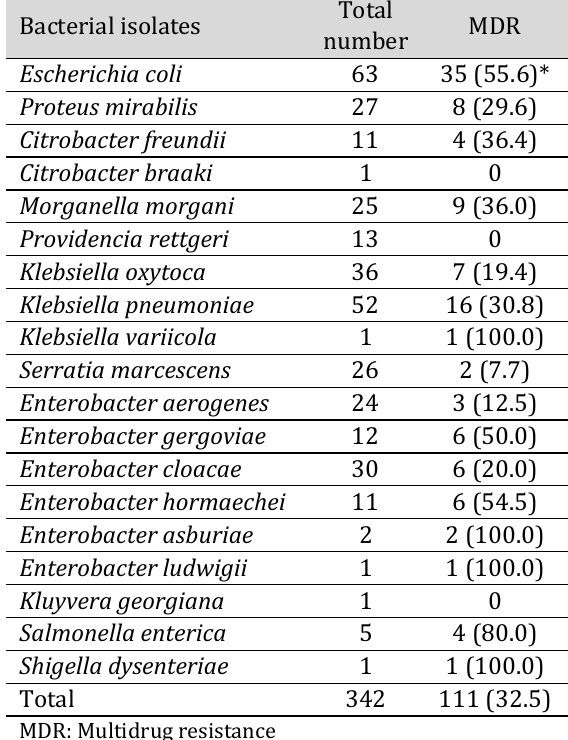
Table 3. Prevalence of MDR phenotype